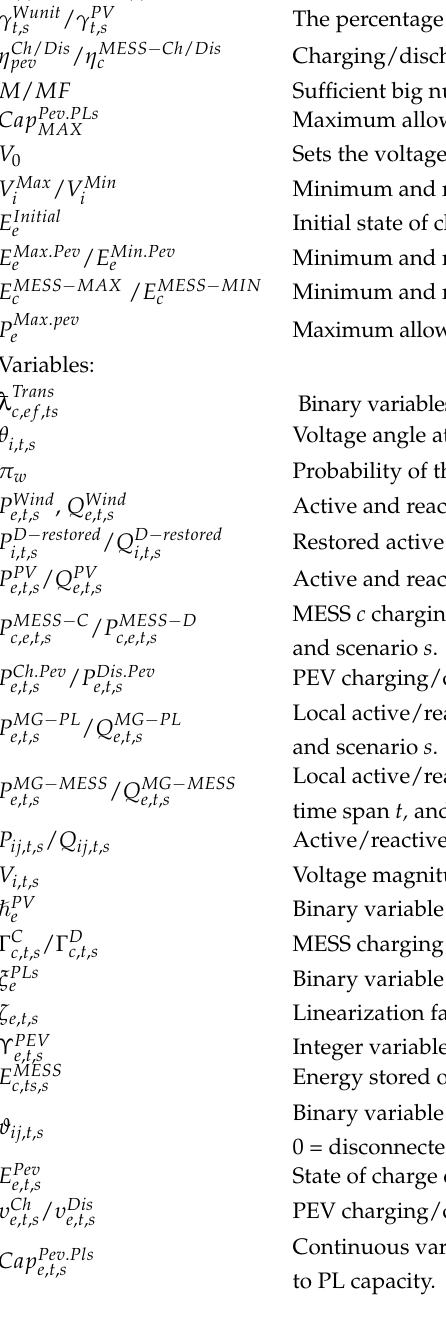
Figure 3. Time ‐ space network (TSN)